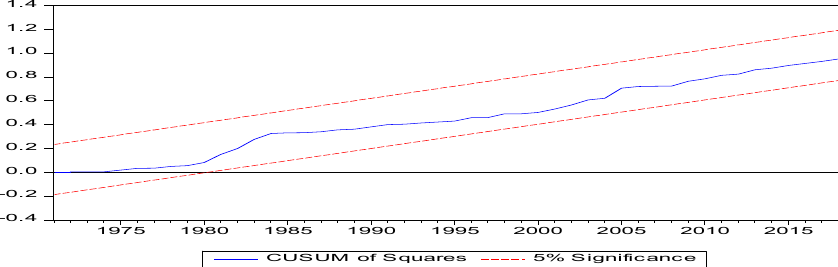
Figure 4. Plot of cumulative sum of squares recursive residual for Life Expectancy Model.